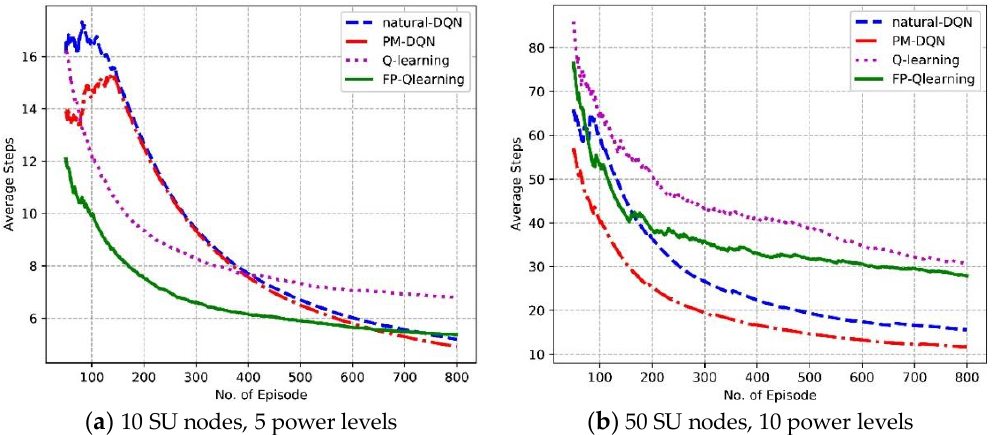
Figure 8. Average steps vs. the number of episodes.